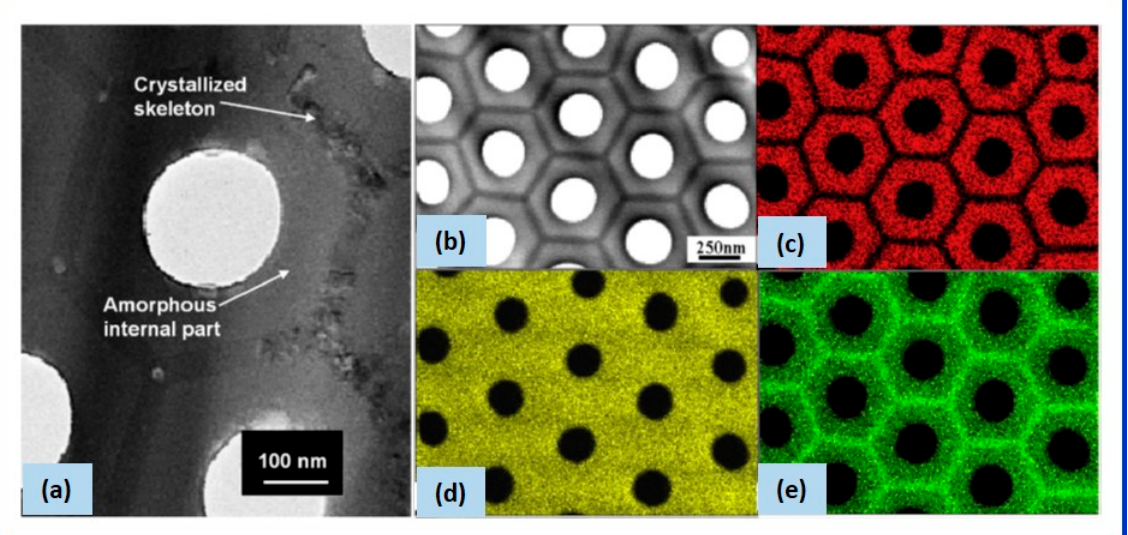
Figure 3. ( a ) NAA cell boundary band showing the pure alumina inner layer (crystalized skeleton) and acid-ion contaminated amorphous outer layer (internal part). The inner layer skeleton got crystallized under the high-electron beam irradiation for 30 s.; ( b ) TEM image of a top view of the NAA prepared in phosphoric acid; and the corresponding elemental maps of ( c ) phosphorus, ( d ) oxygen, and ( e ) aluminum. Reprinted with permission from François Le Coz, Laurent Arurault, and Lucien Datas, Materials characterization 61 (3), 283 (2010). Copyright 2010 Elsevier [92] .